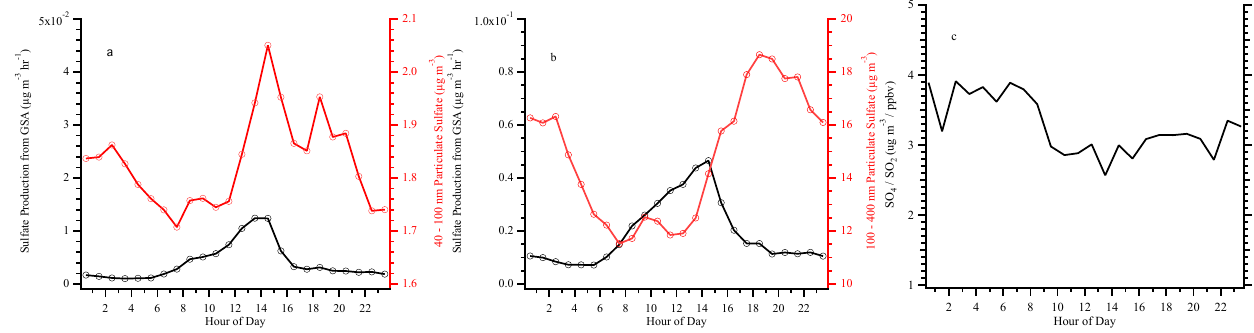
Fig. 6. (a) Diurnal profiles of condensation rates of GSA onto Aitken mode aerosols (40–100nm) and sulfate concentrations in Aitken mode; (b) diurnal profiles of condensation rates of GSA onto accumulation mode particles (100–400nm) and sulfate concentrations in accumulation mode; (c) diurnal profile of PM 1 sulfate (SO 4 ) to SO 2 ratio.